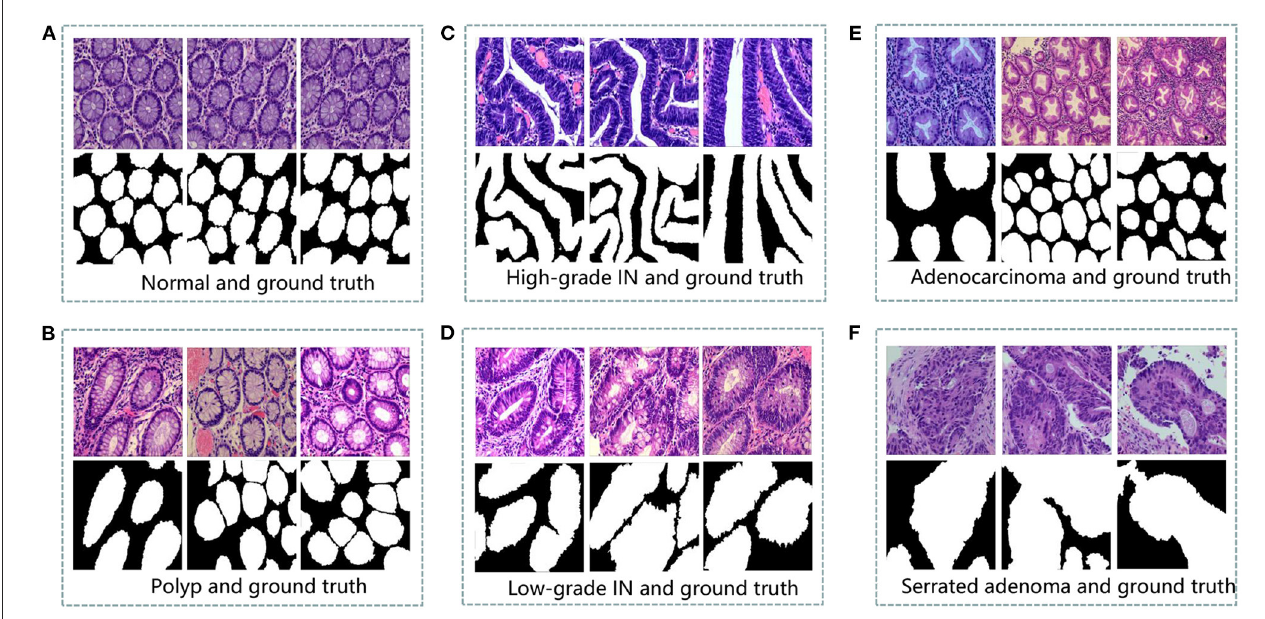
FIGURE1 An example of histopathological images database. (A) Normal and ground truth, (B) Polyp and ground truth, (C) High-grade Intraepithelial Neoplasia and ground truth, (D) Low-grade Intraepithelial Neoplasia and ground truth, (E) Adenocarcinoma and ground truth, and (F) Serrated adenoma and ground truth.